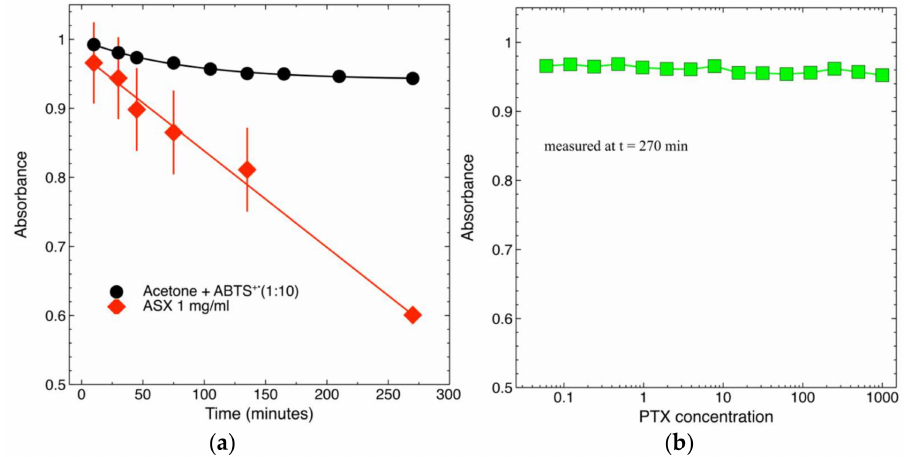
Figure 5. Antioxidant activity of PTX and ASX extracts in a cell free assay. ( a ) Antioxidant kinetics of ASX extracts compared to the spontaneous decay of ABTS cation radicals (ABTS + ) in acetone solvent. ( b ) Antioxidant kinetics of PTX overlapped those of ABTS + · in acetone at all assayed concentrations. For the sake of clarity, in this panel we show only the final time-point, i.e., the measurements carried out after 270 min for all PTX